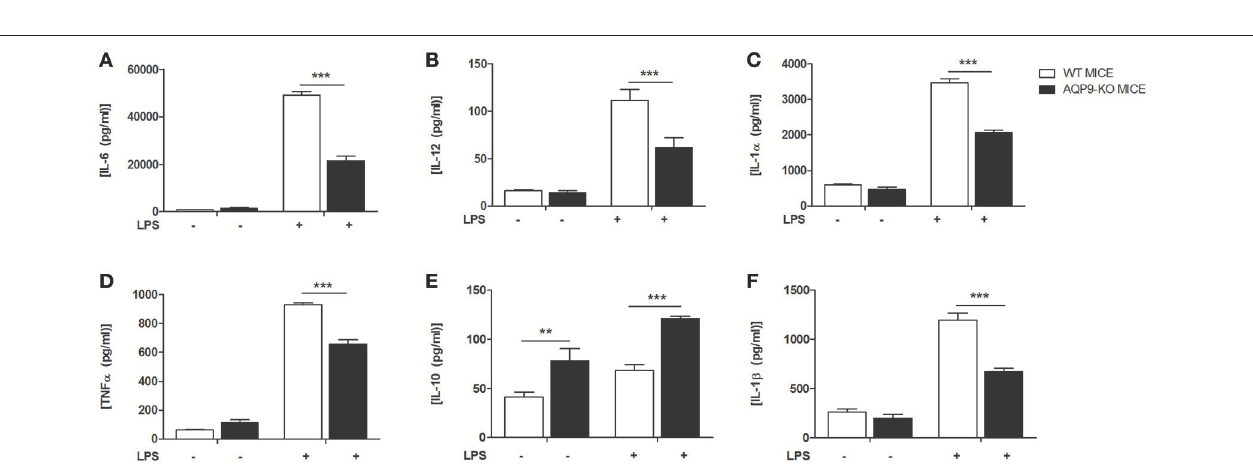
FIGURE 4 | AQP9-KO DCs cytokine profile following LPS exposure. BMDCs from WT and Aqp9-KO mice were exposed to LPS for 24h. (A–F) Cytokine ( IL-6, IL-12, IL-1 α , TNF α , IL-10, IL-1 β ) concentrations were determined in the supernatant by ELISA. Bars represent mean ± SEM of 3 independent experiments. ** P < 0.01, *** P <